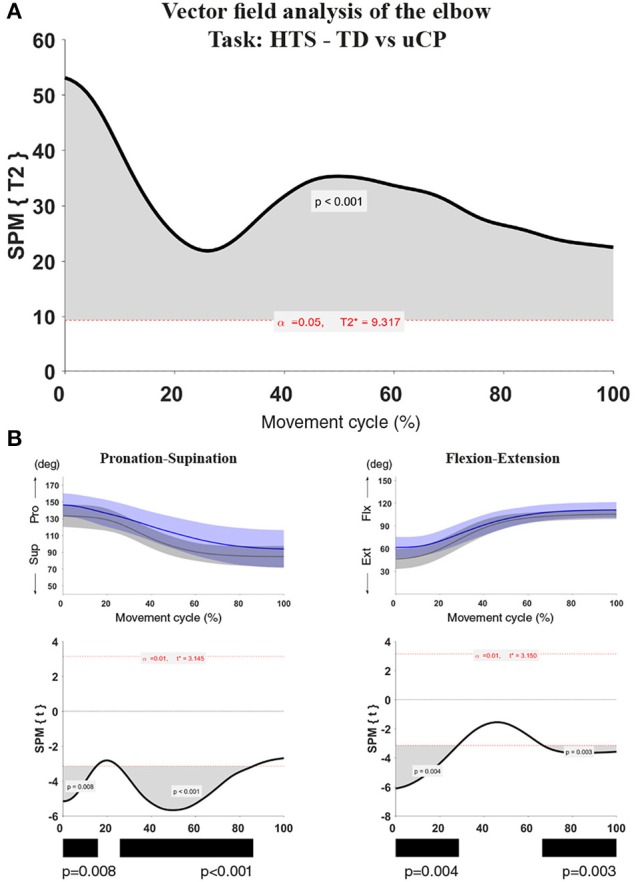
Statistical Parametric Mapping output example for the comparison of elbow kinematics (two vector components) during the HTS task between children with uCP and TDC. (A) Hoteling's test output with one cluster over 100% of the movement cycle, the bold black line is the computed t-curve, the dashed red line indicates the random theory threshold calculated for this test (at 9.317 for α < 0.05). Over 100% of the movement cycle, the vectors of the TDC and uCP group are significantly different; (B) Elbow vector decomposition (left: pro-supination; right: flexion-extension) with mean (bold line) and standard deviation (translucent area) of the TDC (gray) and uCP (blue) group. Below, the SPM{t} output correspondent to each of the vector components. Children with uCP show increased elbow flexion over 28 and 33% of the movement cycle in two different clusters (cluster 1: 0–28%, p < 0.01; cluster 2: 67–100%, p < 0.01) and increased pronation over 15 and 61% of the movement cycle in two different clusters (cluster 1: 0–15%, p < 0.01; cluster 2: 25–86%, p < 0.01). The black bars under each SPM{t} output correspond to the identified clusters. The SPM output will be represented in this summarized manner throughout the manuscript.